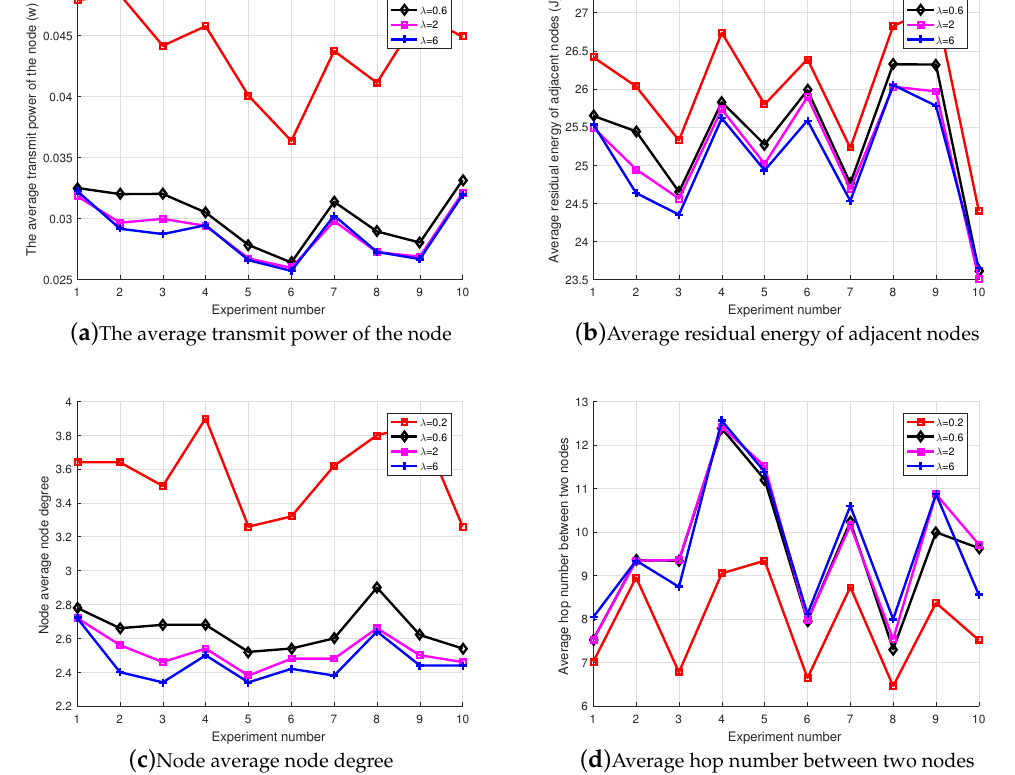
Figure 3. The impact of λ on network